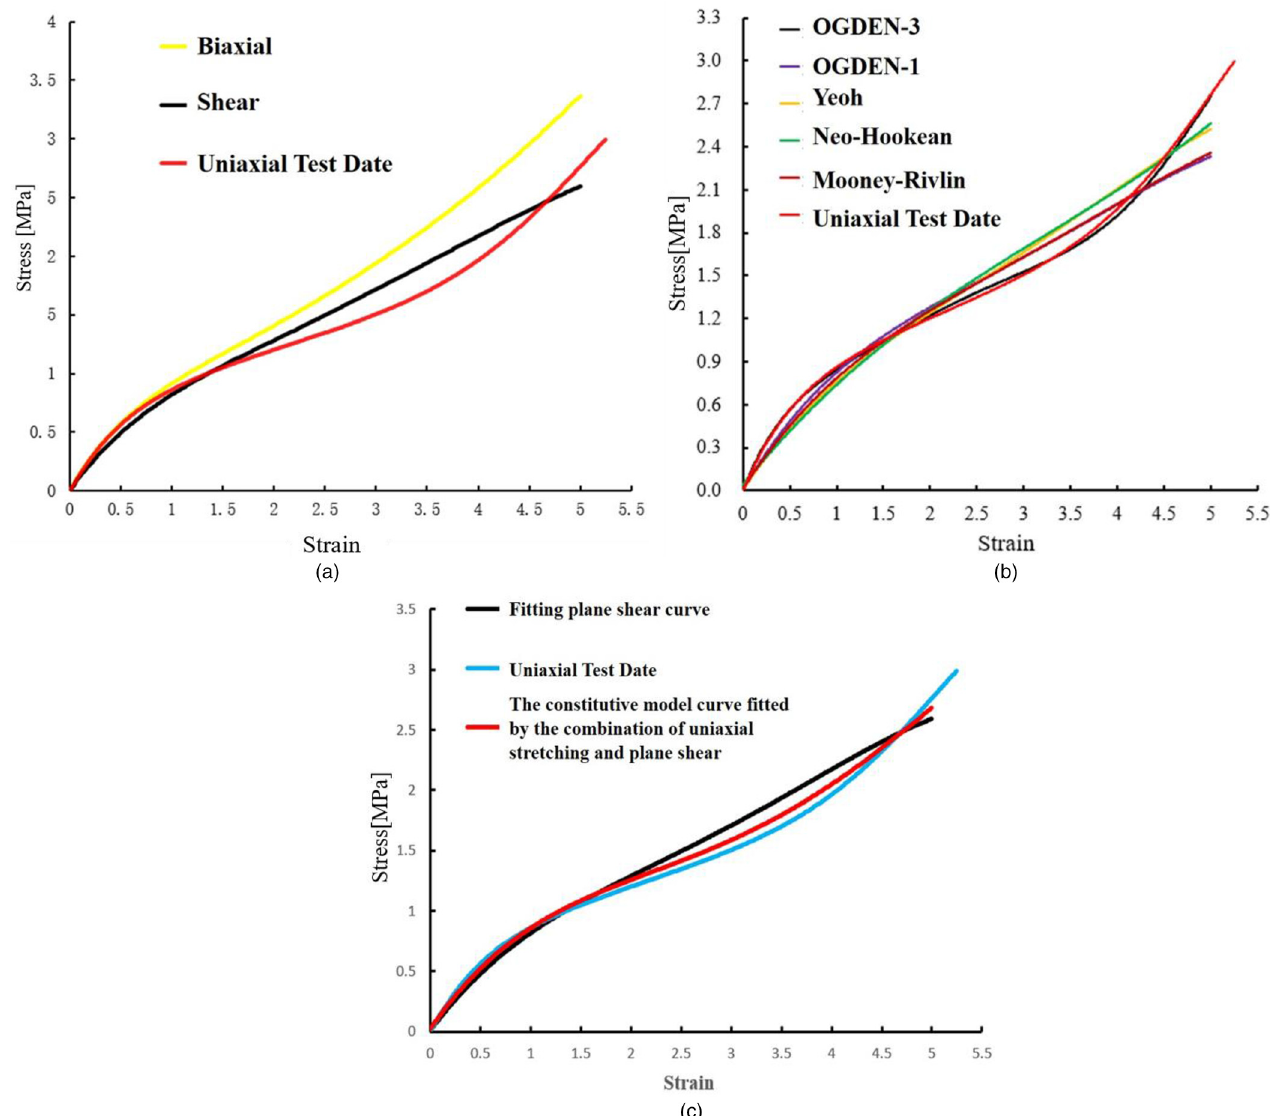
Fig. 2. Fitting curve of fatigue test and simulation. (a) Stress – strain curve of uniaxial tensile test. (b) Fitting curves of different rubber constitutive models. (c) Fitting curve of the combination of uniaxial tensile and plane